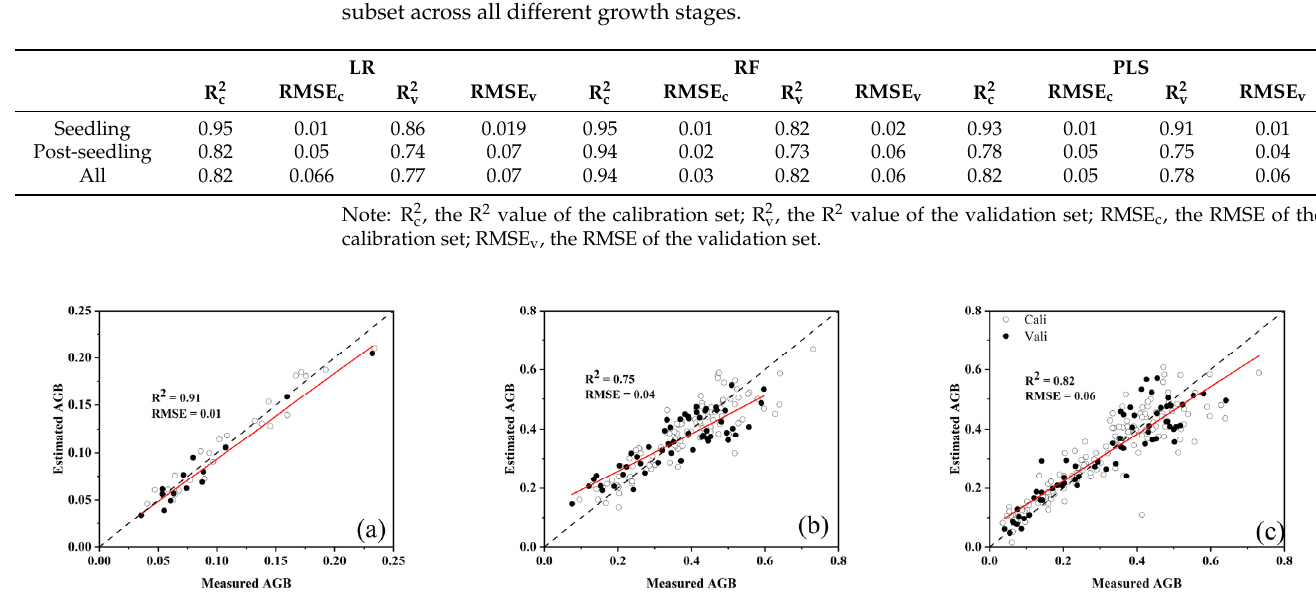
Figure 11. Validation of aboveground biomass (AGB) estimation models established by best per- forming optimal normalized di ff erence texture index subset vs. AGB for the following stages: ( a ) seedling, ( b ) post-seedling, ( c ) all